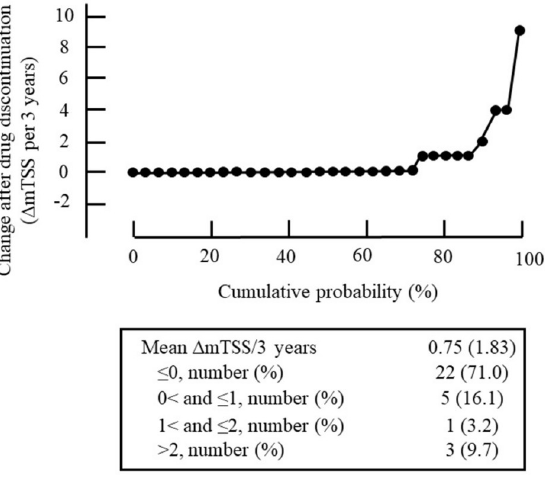
Fig 3. Structural outcome: Cumulative probability plot of the change in mTSS due to bDMARD/tofacitinib discontinuation over 3 years. mTSS, van der Heijde-modified total Sharp score.